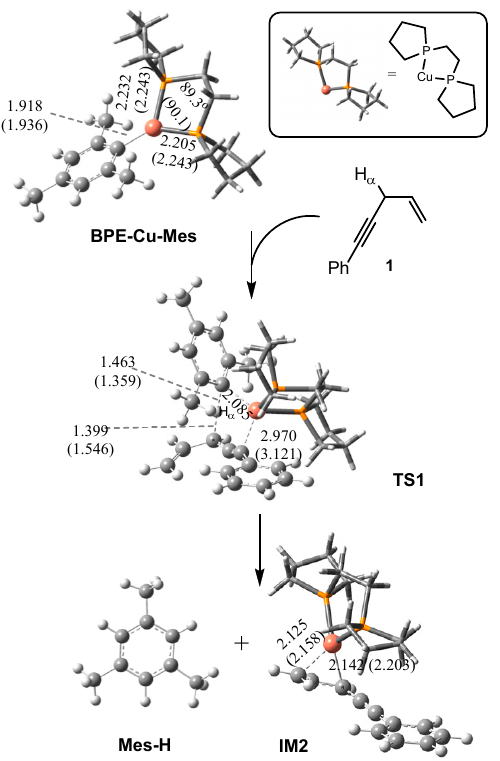
Figure 1. Optimized structures along the reaction from the reactants to IM2 at the M06/6-31G(d,p) level and B3LYP/6-31G(d,p) in parentheses. Bond lengths are in angstroms and the angles are in degrees.